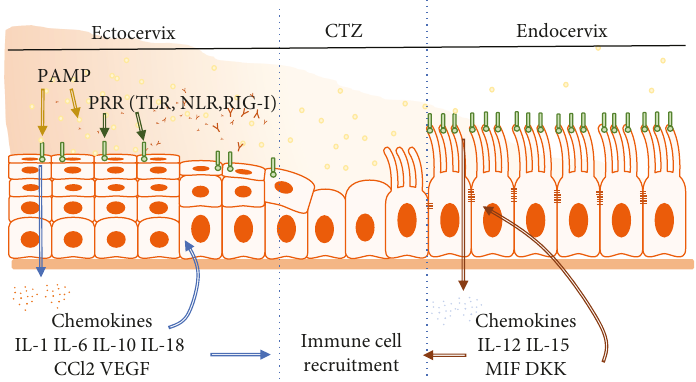
Figure 7: Chemokine pro fi le and distribution in the ecto- and endocervix. Chemokine pro fi le. Full names of abbreviations: interleukin (1, 6, 10, 12, 15, 18), vascular endothelial growth factor (VEGF), macrophage migration inhibitory factor (MIF) and dickkopf homolog 1 (DKK1), pathogen-associated molecular patterns (PAMPs), and pattern recognition receptor